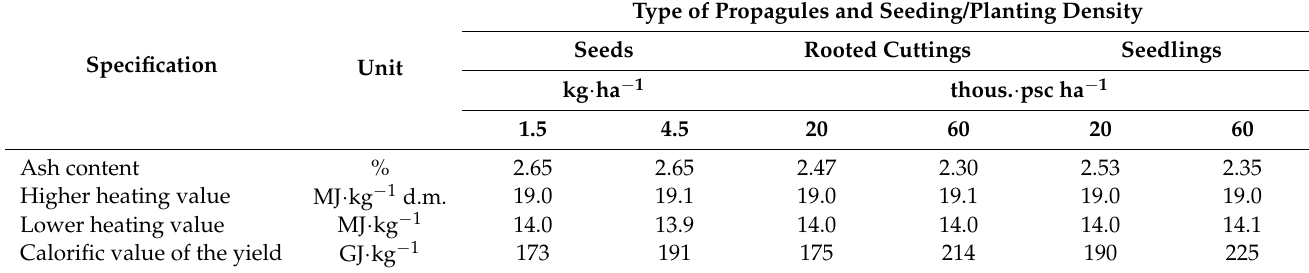
Table 13. Characteristics of Virginia fanpetal biomass as a fuel